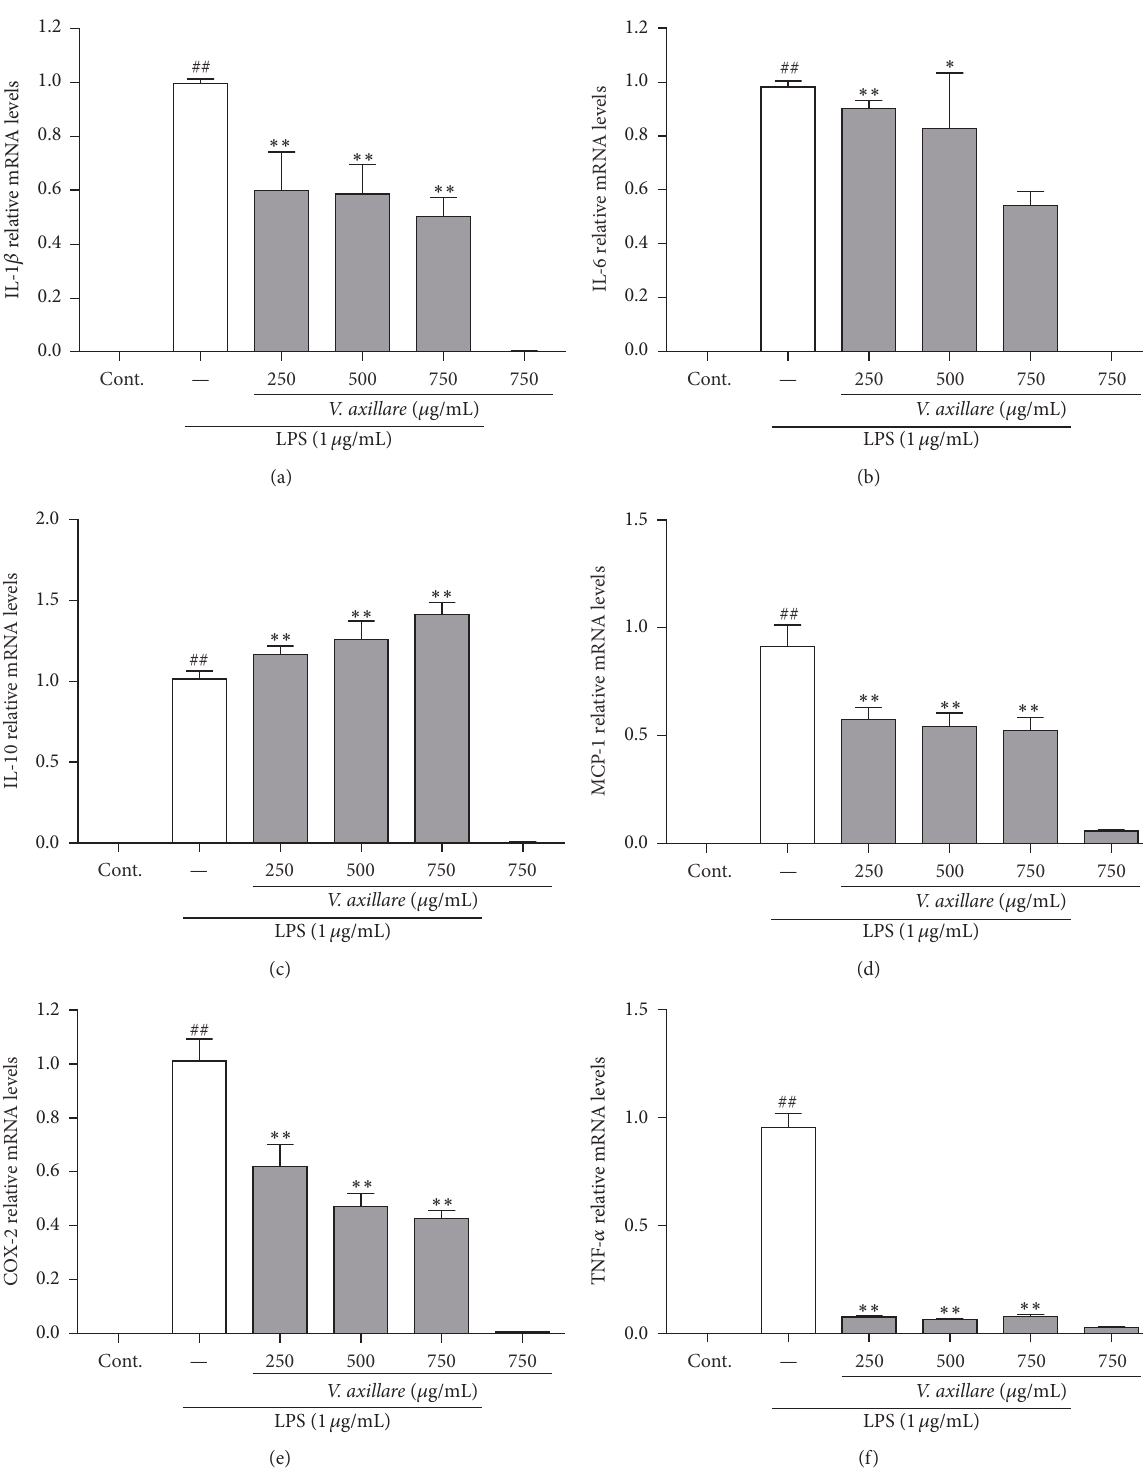
Figure 4: Effects of V. axillare on the gene expression of key proinflammatory genes in LPS-stimulated RAW264.7 cells. Various concentrations of V. axillare (250, 500, and 750 𝜇 g/mL) were treated to the cells for 1 h before incubation with LPS (1 𝜇 g/mL) for 6 h. Additionally, one group was treated with V. axillare (750 𝜇 g/mL) alone to observe the effects of V. axillare on the RAW264.7 without LPS stimulation. The mRNA expression of (a) IL-1 𝛽 , (b) IL-6, (c) IL-10, (d) MCP-1, (e) COX-2, and (f) TNF- 𝛼 was analyzed by qRT-PCR. Data are presented as the mean ± SD from three independent experiments. Student’s 𝑡 -test was performed to compare individual groups ( ∗ 𝑝 < 0.05 and ∗∗ 𝑝 < 0.01 indicate a significant difference compared with the LPS group; ## 𝑝 < 0.01 indicates a significant difference compared with the untreated